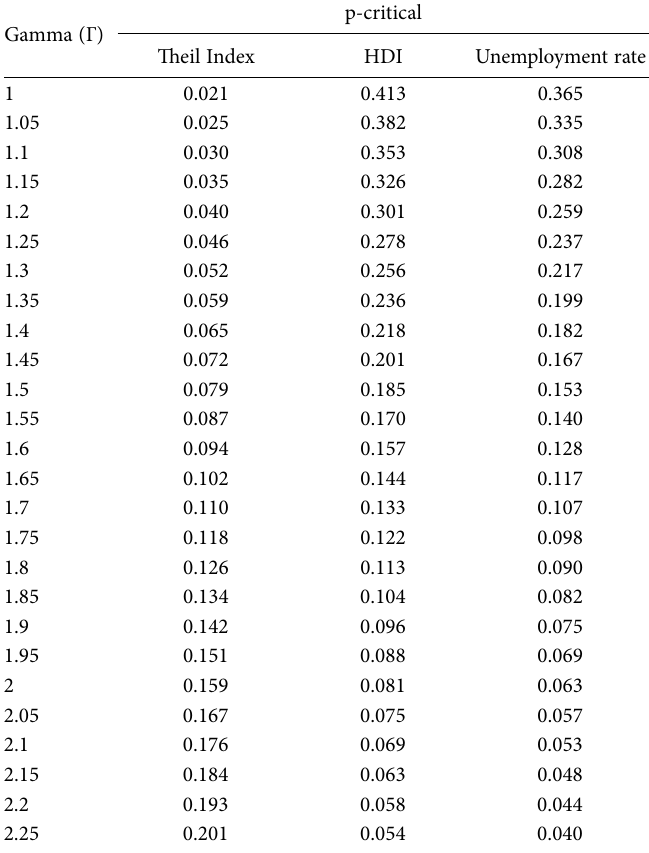
Table 5. Results of the Rosenbaum sensitivity